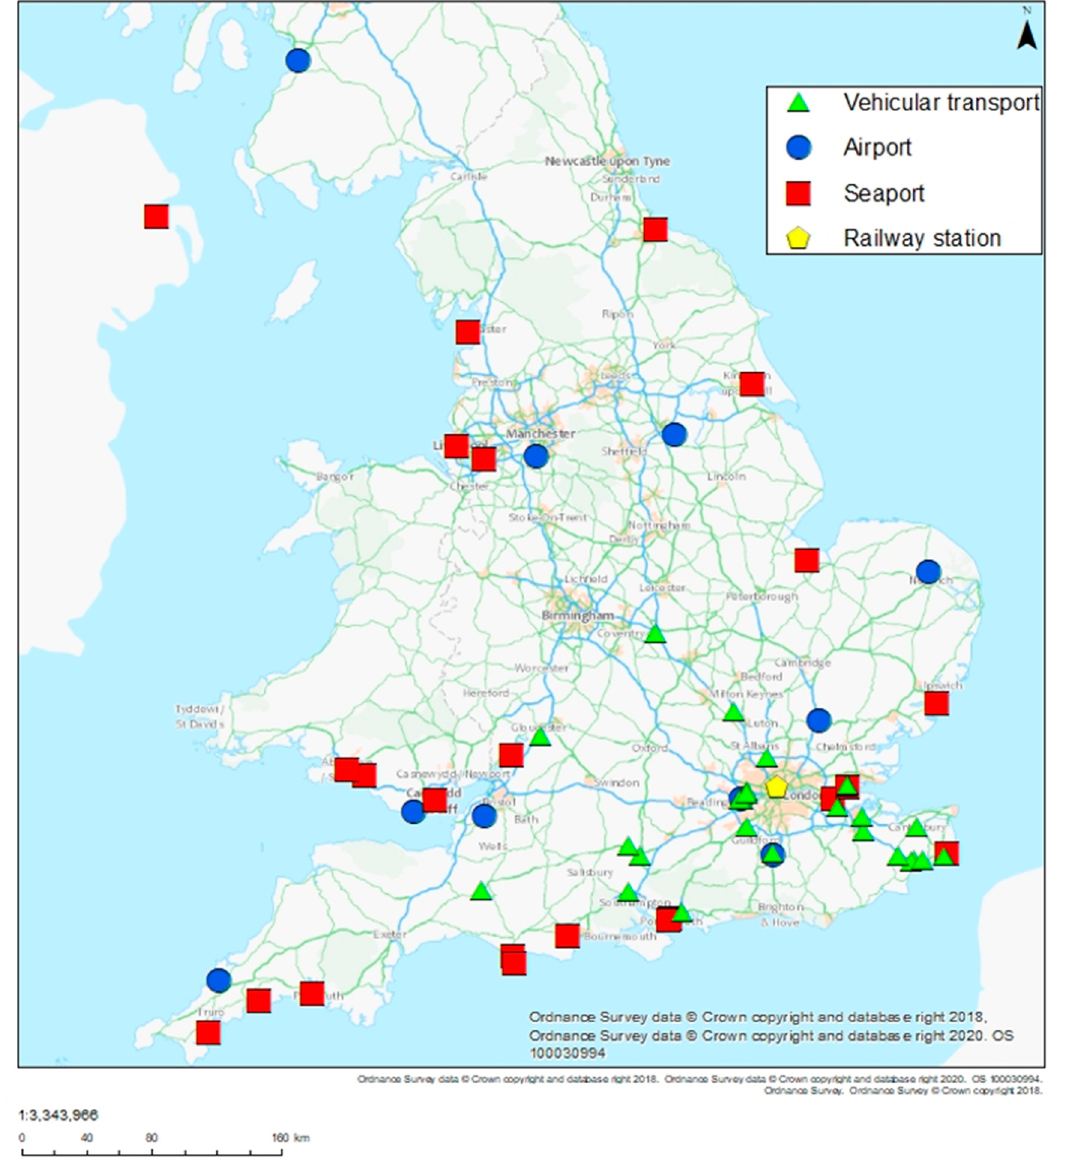
Figure1. Surveillancelocationsshownbycategory: airport, seaport, railwaystation, Figure 1. Surveillance locations shown by category: airport, seaport, railway station, vehicular transport.